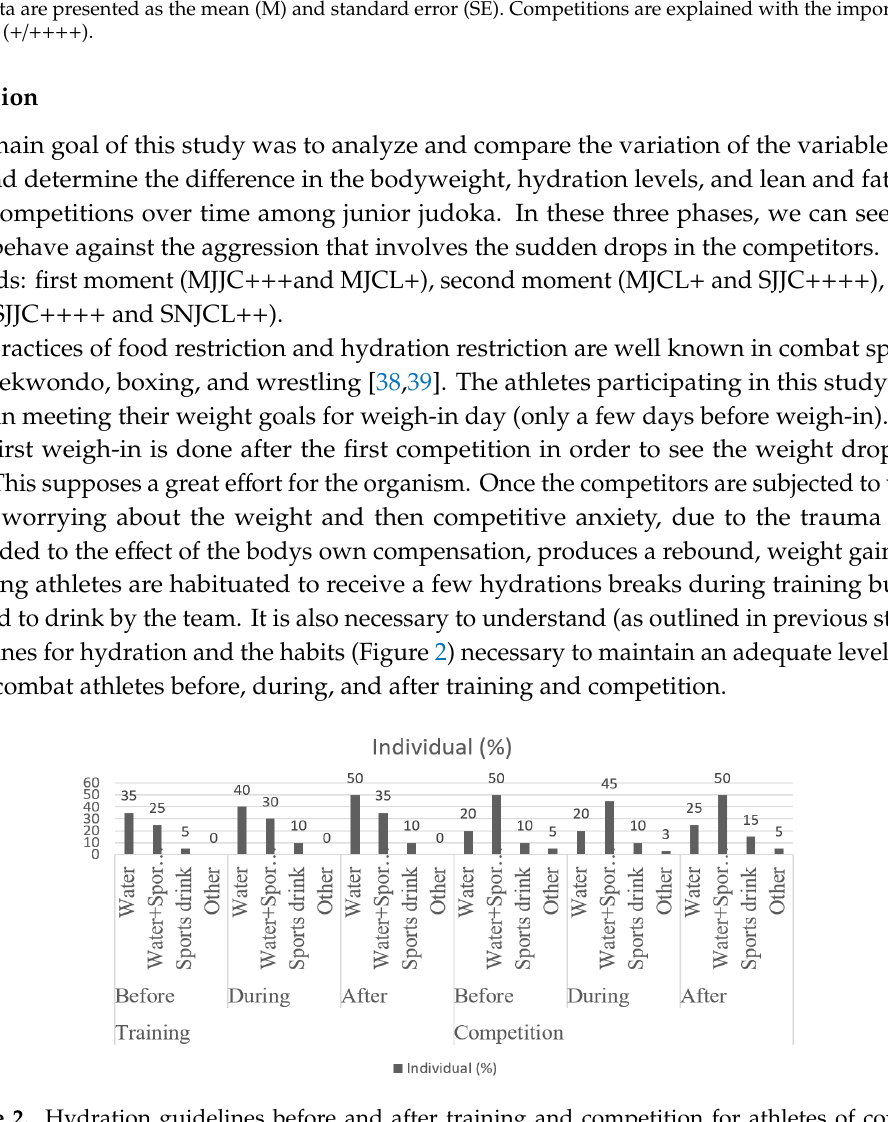
Figure 2. Hydration guidelines before and after training and competition for athletes of combat modalities (taekwondo, judo, and boxing). Adapted [2]. Water/Water + sport drink/sports drink/Other